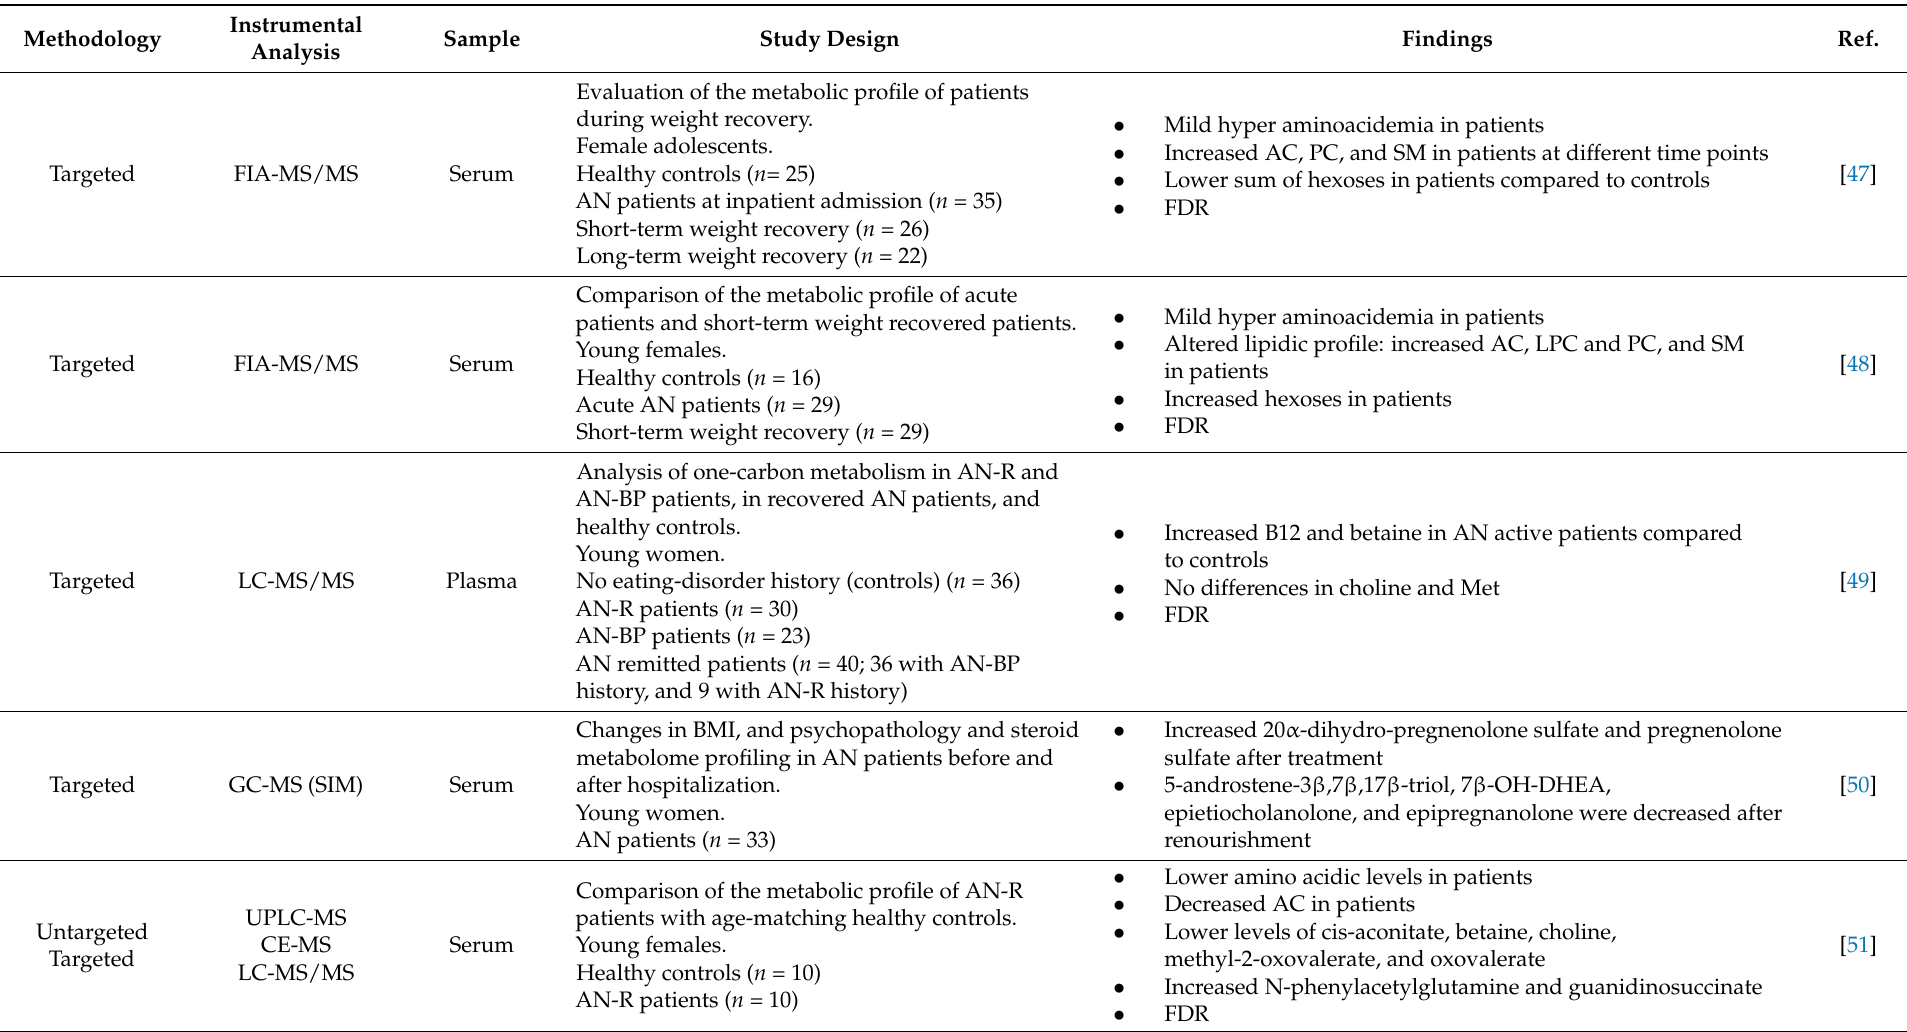
Table 1. Metabolomics studies on AN in